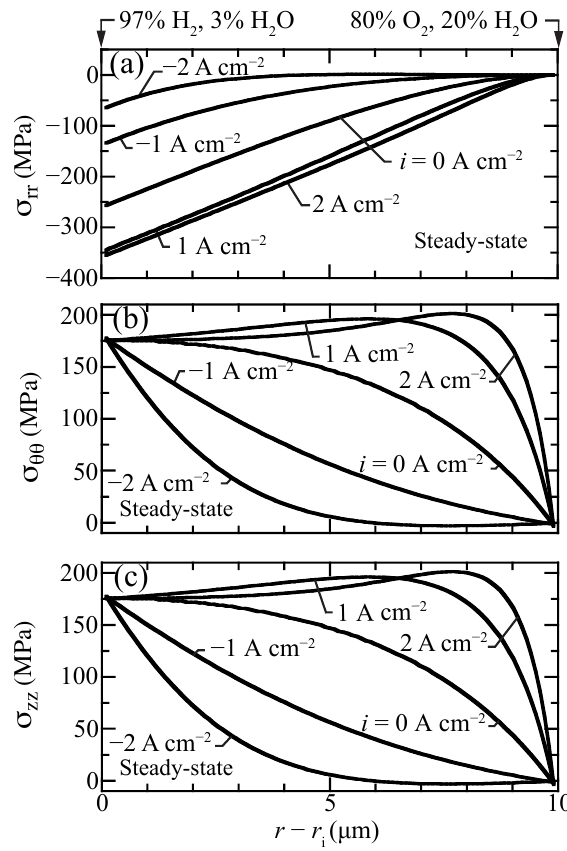
Figure 8. Steady-state stress-contribution profiles for selected current densities ( i = − 2, − 1,0, 1,2 A cm − 2 ) with the cell operating at 600 ◦ C. ( a ) radial, ( b ) hoop, and ( c ) axial stress